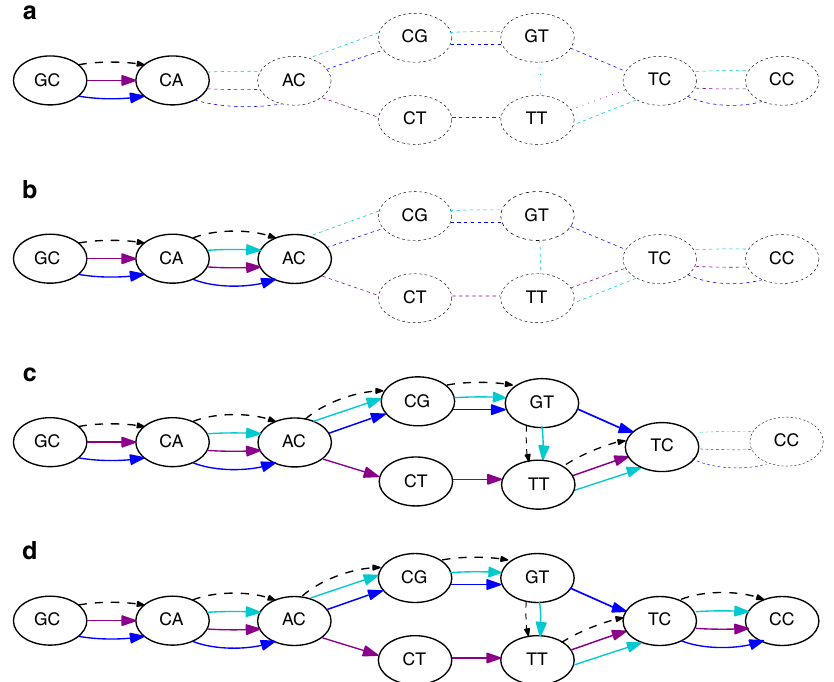
Fig. 2 An example of running Algorithm Find-collinear-blocks (Box 1) on the graph from Fig. 1b, starting from edge GC → CC as the seed. Each sub fi gure shows the content of the collinear block P and the carrying path. The collinear walks are solid, the carrying path is dashed, and the rest of the graph is dotted. Sub fi gure a shows the state of these variables after the initialization; sub fi gures b – d show the state after the completion of each phase.